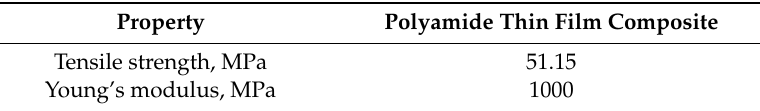
Table 1. Mechanical properties of polyamide membrane.